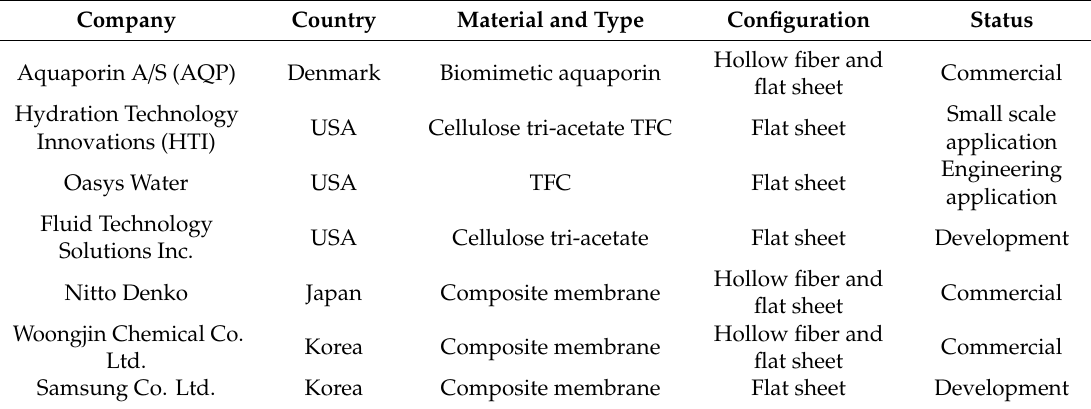
Table 1. List of commercial membrane